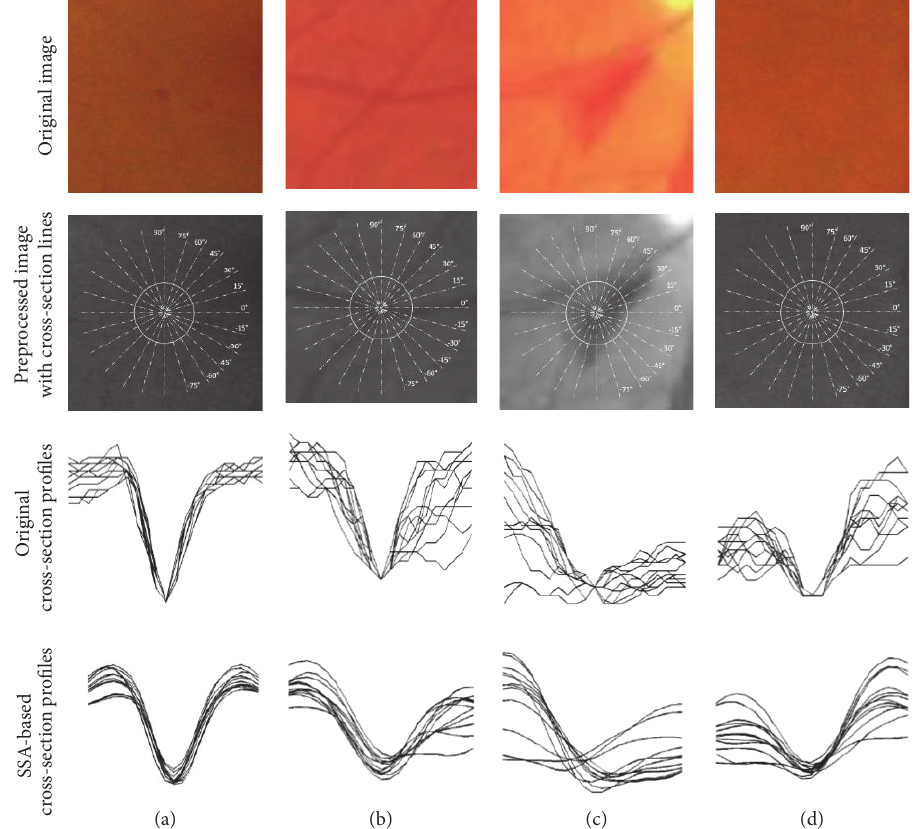
Figure1:SSAcross-sectionprofilesofdifferentobjects.(a)MA,(b)bloodvesselscrossing,(c)haemorrhage(anelongatednon-MAstructure), and (d) a retinal background. The white circles in the middle of the images indicate the actual cross-section scanning regions with 31-pixel